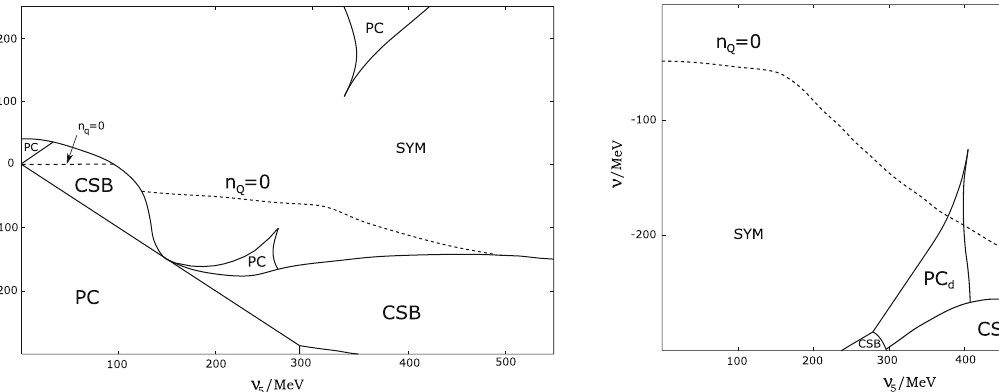
Fig. 3 The (ν 5 ,ν) -phase diagram of β -equilibrium quark matter (see the models (7), (8)) at μ = 300 MeV and μ 5 = 0 in the chiral limit, m 0 = 0. CSB is the notation for the chiral symmetry breaking phase. Along the dashed line the electric charge density is zero, n Q = 0. Other notations are the same as in Fig. 1